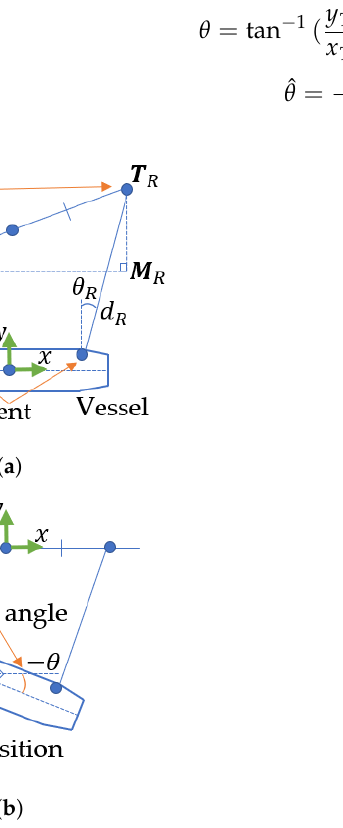
Figure 3. Coordinate system for vessel positioning: ( a ) vessel-based coordinate system; ( b ) quay- based coordinate